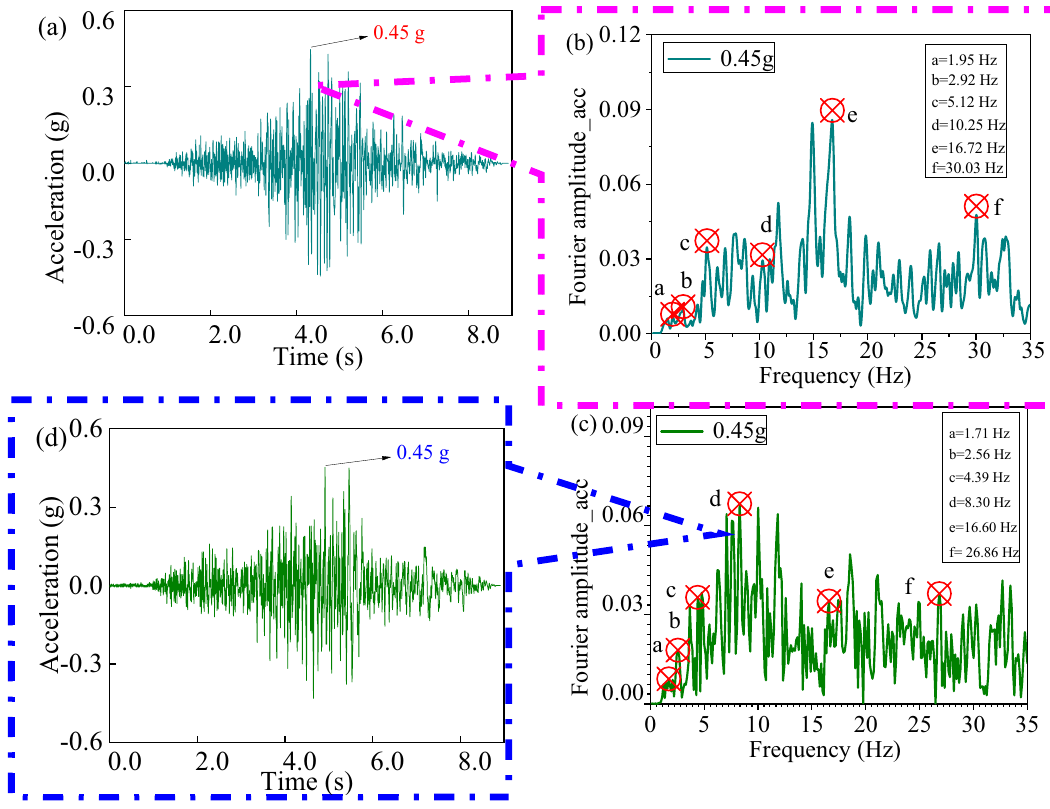
Figure 9. Northridge waves used for the ST test ( a ) in the x -direction; ( d ) in the y -direction; ( b ) Fourier spectrum of the earthquake wave for the x -direction; and ( c ) Fourier spectrum of the earthquake wave for the y -direction.